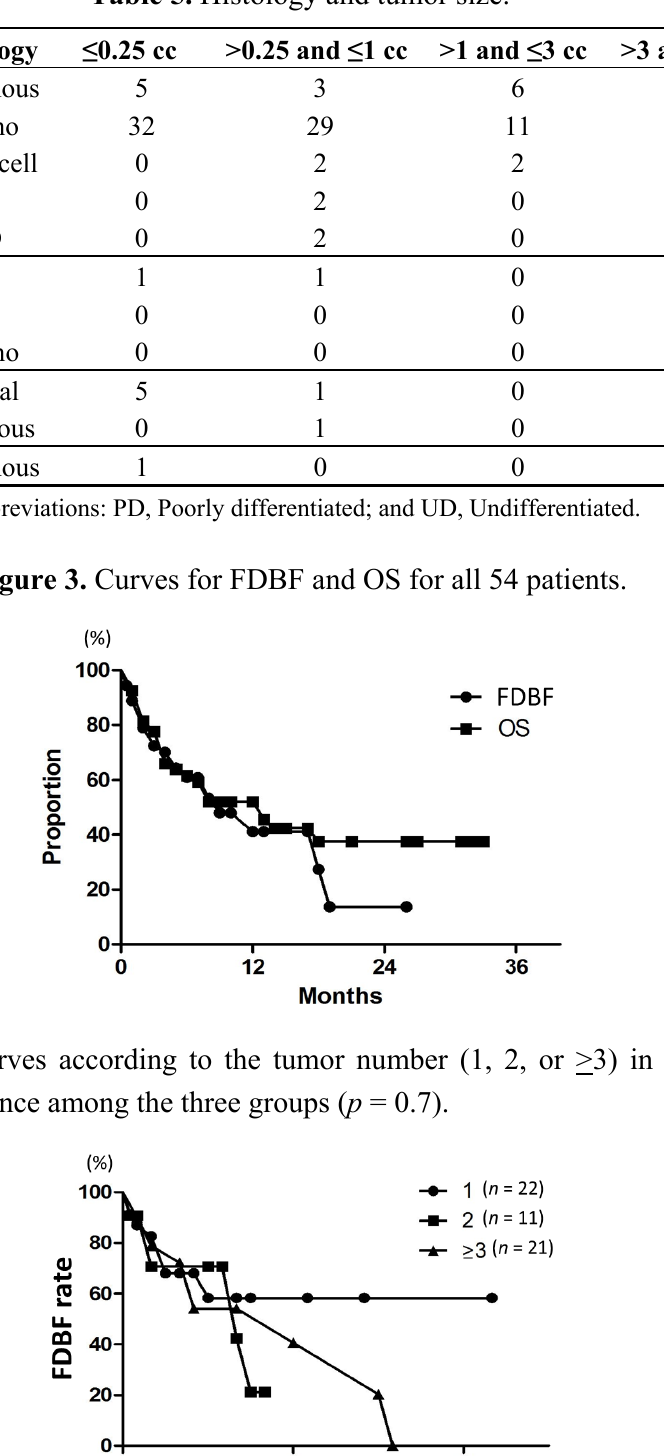
Table 5. Histology and tumor size.